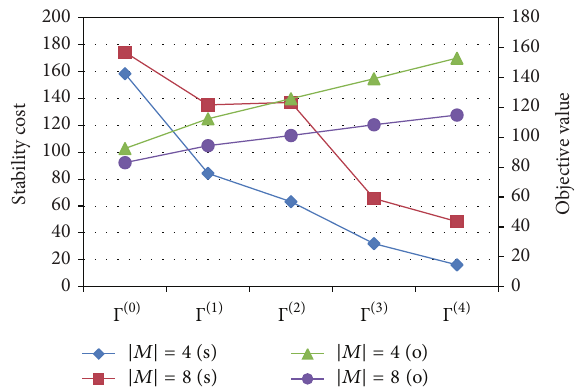
Figure 4: Impact of the number of modes on the schedule stability ( |𝑁| = 20 , OS = 0.5